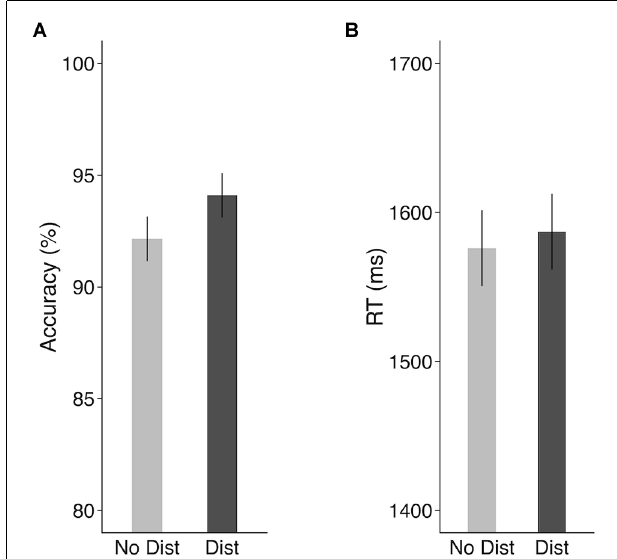
FIGURE 2 | Behavioral results in the scanner in the fMRI experiment. (A) Accuracy and (B) response times. Error bars represent 95% within-subjects confidence intervals around the mean. No Dist, no-distractor condition; Dist, distractor